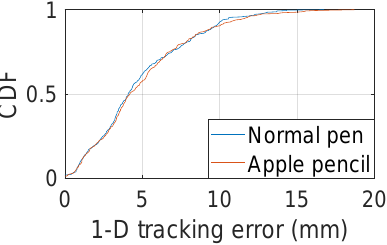
Figure 6. 1-D tracking errors with a normal pen and the Apple